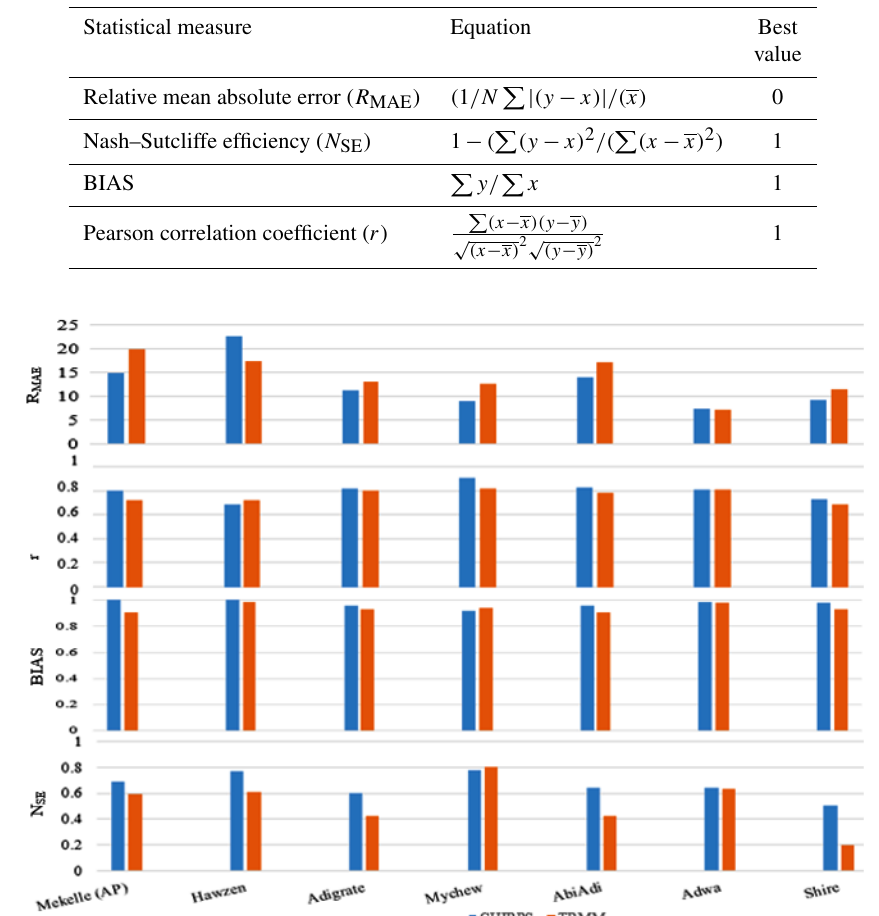
Figure 2. Comparison of satellite rainfall data against measured rainfall